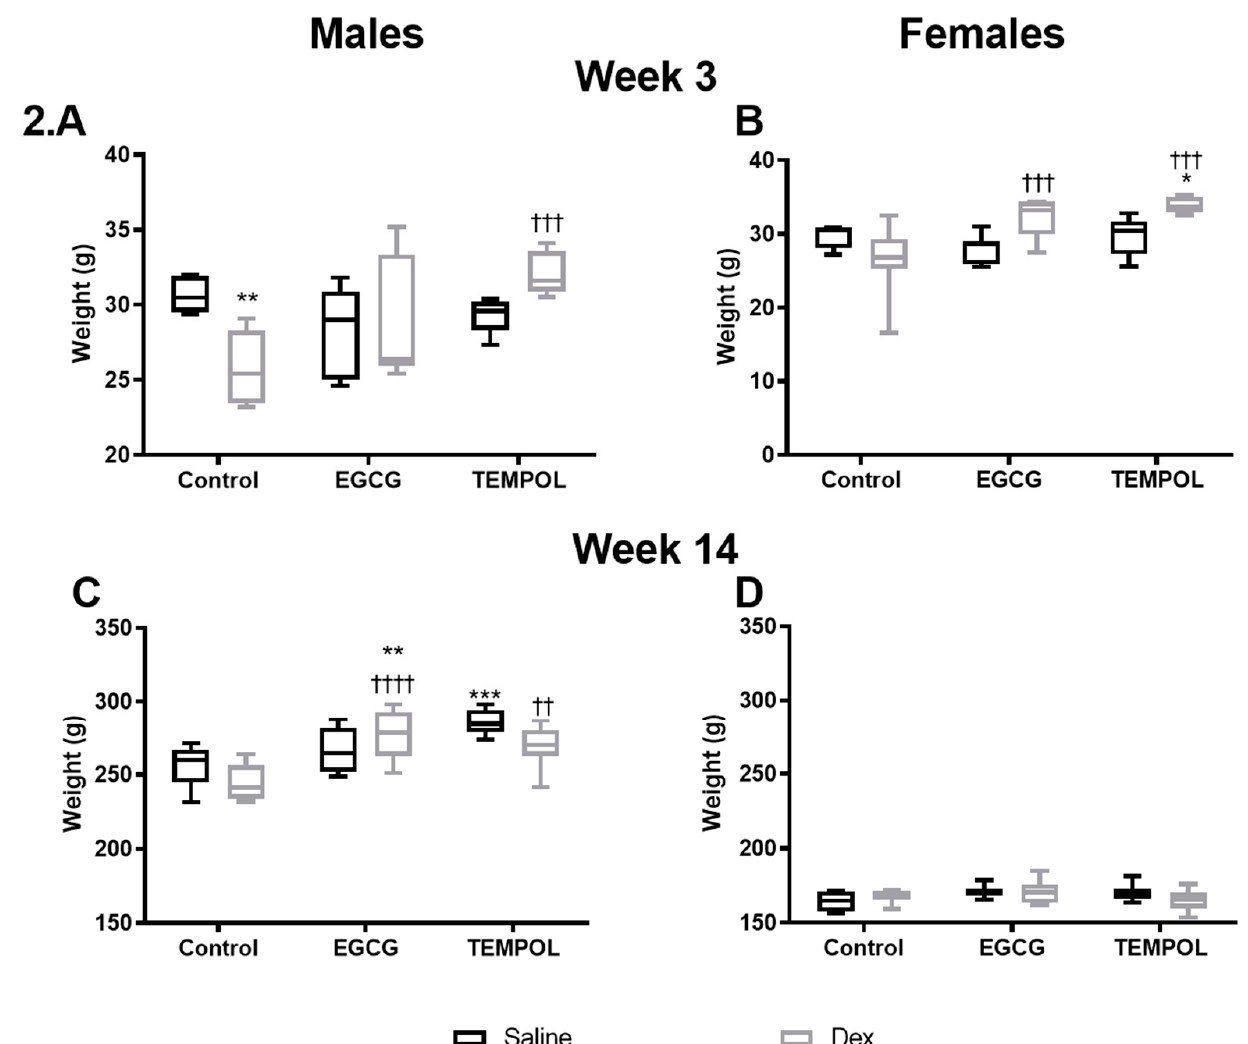
Figure 2. Offspring body weight. The effects of maternal antioxidant administration on offspring body weight at week 3 for males ( A ) and females ( B ) and week 14 males ( C ) and females ( D ) in programmed (Grey) and unprogrammed animals (Black). Saline and Dex control have been published previously and have been provided for reference [7]. Two-way ANOVAs were performed (Fisher’s LSD test). * is used to indicate significance; * p ≤ 0.05, **/†† p ≤ 0.01, ***/††† p ≤ 0.001, †††† p ≤ 0.0001. Comparison to the Control-Saline group is represented with the symbol (*) and (†) for the Control-Dex offspring. N = 6 per group. Significant interactions were present for week 3 and 14 between maternal injection and antioxidant administration for males and